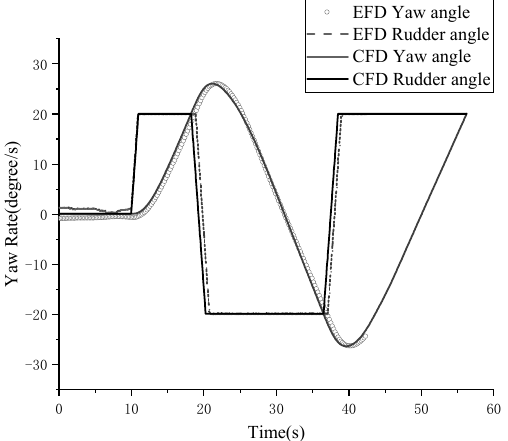
Figure 26. Yaw rate in − 10° zigzag maneuver.